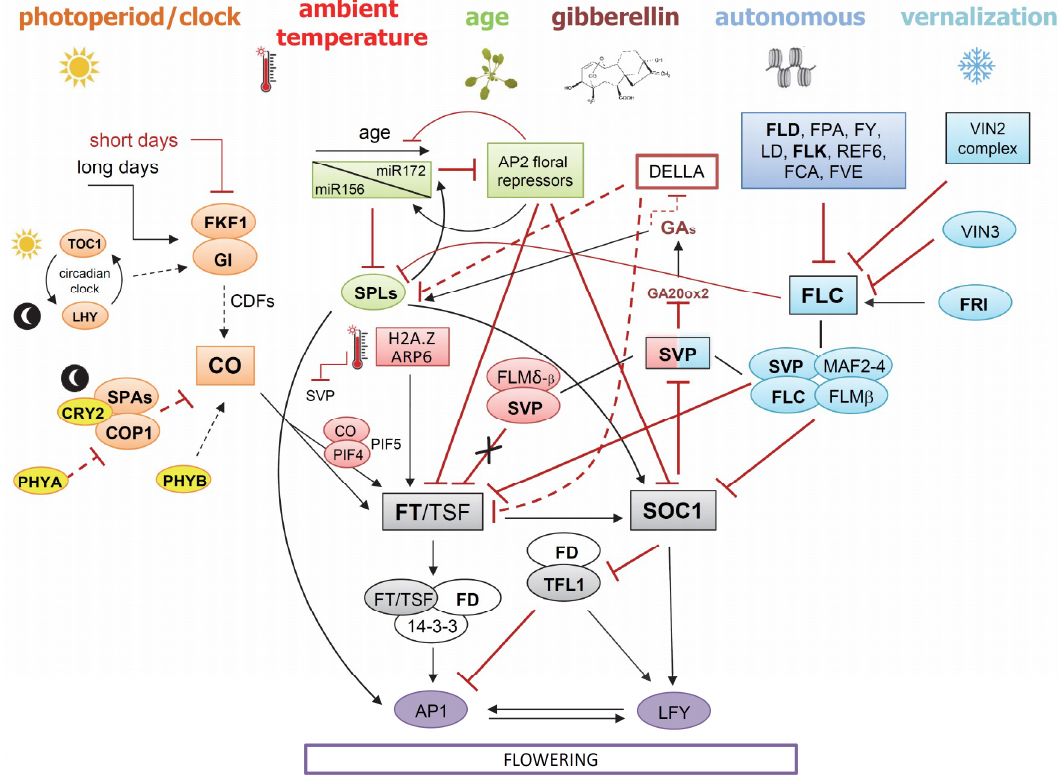
Figure 4. Main flowering time pathways acting in Arabidopsis thaliana : Photoperiod (orange and yellow), ambient temperature (red), age (green), gibberellins (brown), autonomous (sky blue), vernalization (light blue). Grey boxes represent the main floral integrators FT/TSF and SOC1. The two main genes conferring inflorescence meristem identity, AP1 and LFY , are indicated in purple. Squared boxes indicate genes having a pivotal role in the specific pathway. Boxes with rounded corners represent several genes or complexes. Solid and dotted lines indicate either direct or indirect regulation, black arrows and red T-ends indicate positive or negative regulation, respectively. The cartoon represents only the main regulatory genes in the different pathways, whereas the complete flowering time network, involving more than 300 genes, is available at the WikiPathways Web Site [33].